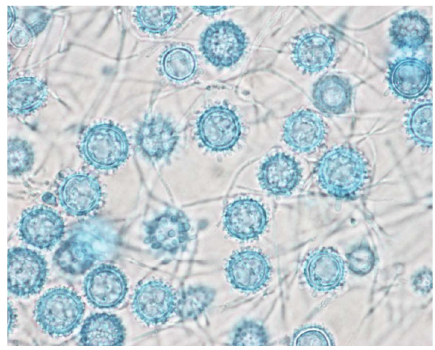
Figure 4: Histoplasma lactophenol cotton blue tape preps, 1000x, from the right knee joint aspirate